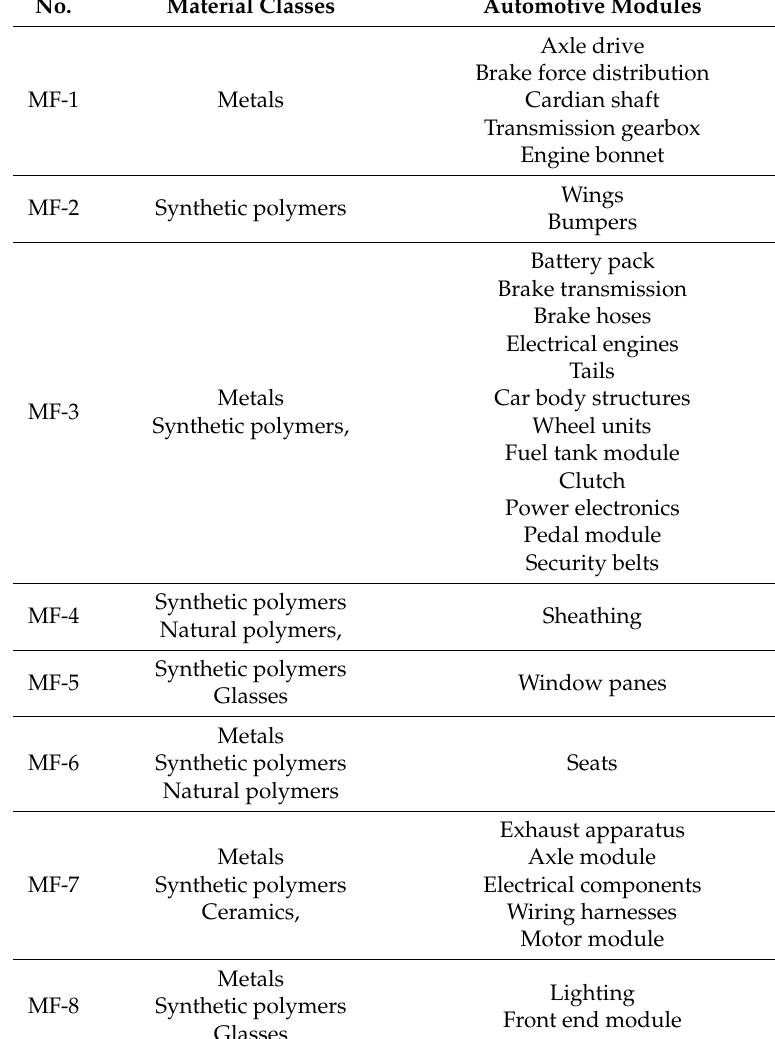
Table A3. Classification of automotive modules according to the material they are made of